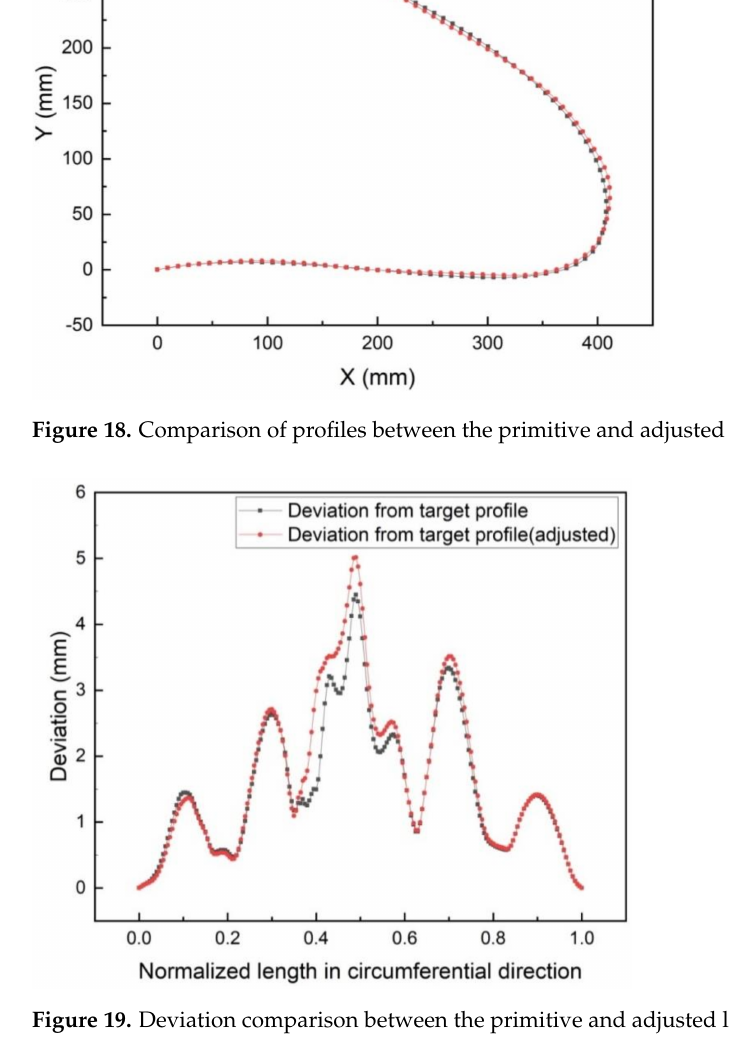
Figure 19. Deviation comparison between the primitive and adjusted layup in drooped